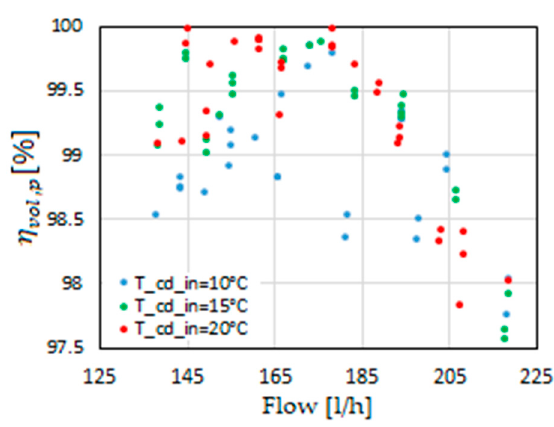
Figure 5. Refrigerant pump volumetric efficiency with the flow rate.